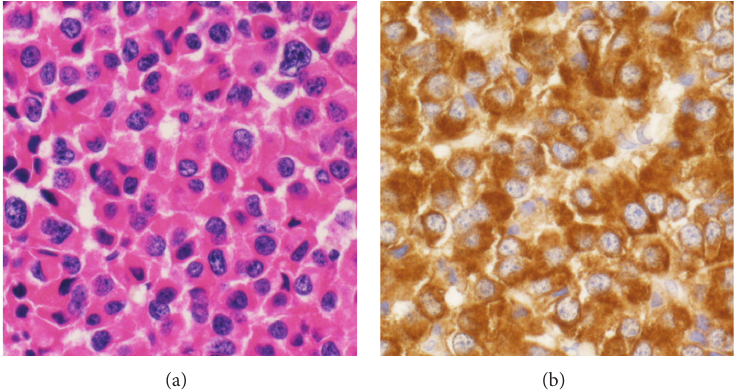
Figure 4: (a) Photomicrograph shows the tumor is composed of monotonous eosinophilic cells. (H&E stain, original magnification × 400.) (b) Positive staining is observed with GH immunohistochemistry. (GH, original magnification ×